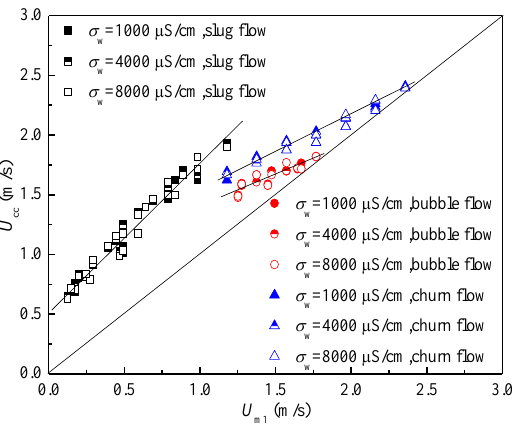
Figure 12. The relationships between U cc and U m1 under three typical flow patterns and water Figure 12. Therelationshipsbetween U cc and U m1 conductivities.